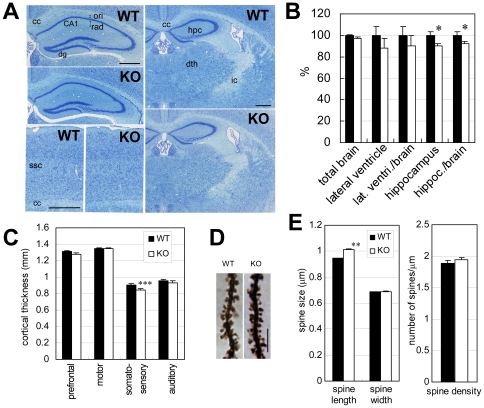
Morphological abnormalities in the Lrrtm1 KO brain.(A) Histological examination of the hippocampus, thalamus, and cerebral cortex from WT and Lrrtm1 KO mice. Scale bar, 0.5 mm. CA1, hippocampal CA1 area; cc, corpus callosum; dg, dentate gyrus; dth, dorsal thalamic nuclei; hpc, hippocampus; ic, internal capsule; ori, stratum oriens; rad, stratum radiatum; ssc, somatosensory cortex. (B) Volumetric analysis using MRI. Ten pairs of 36-week-old WT and Lrrtm1 KO mice were subjected to in vivo analysis. (C) Thickness of cerebral cortices. Histological sections through prefrontal cortex, motor cortex, somatosensory cortex, and auditory cortex were subjected to morphometric analysis. (D) Spine morphology. Golgi-impregnation staining of hippocampal CA1 pyramidal neuron dendrites. Scale bar, 5 µm. (E) Length and width of spines (left) and number of spines (right) are quantified from secondary or tertiary dendrite segments (more than 20 µm; WT, 58 from 5 mice; KO, 53 from 4 mice). Mean values for each segment were analyzed. Black bars, WT; open bars, KO. Values are presented as means ±SEM. * P<0.05; ** P<0.01; *** P<0.001.